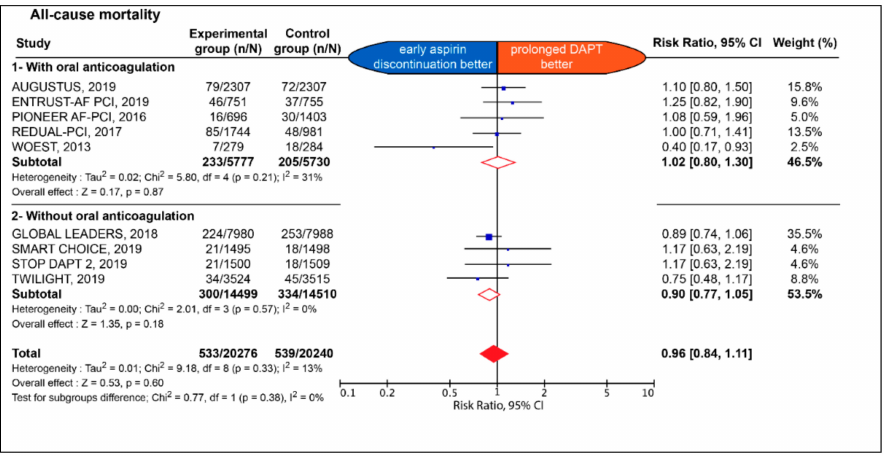
Figure 2. Estimate risk of all-cause death. CI: confidence interval; DAPT: dual antiplatelet therapy.